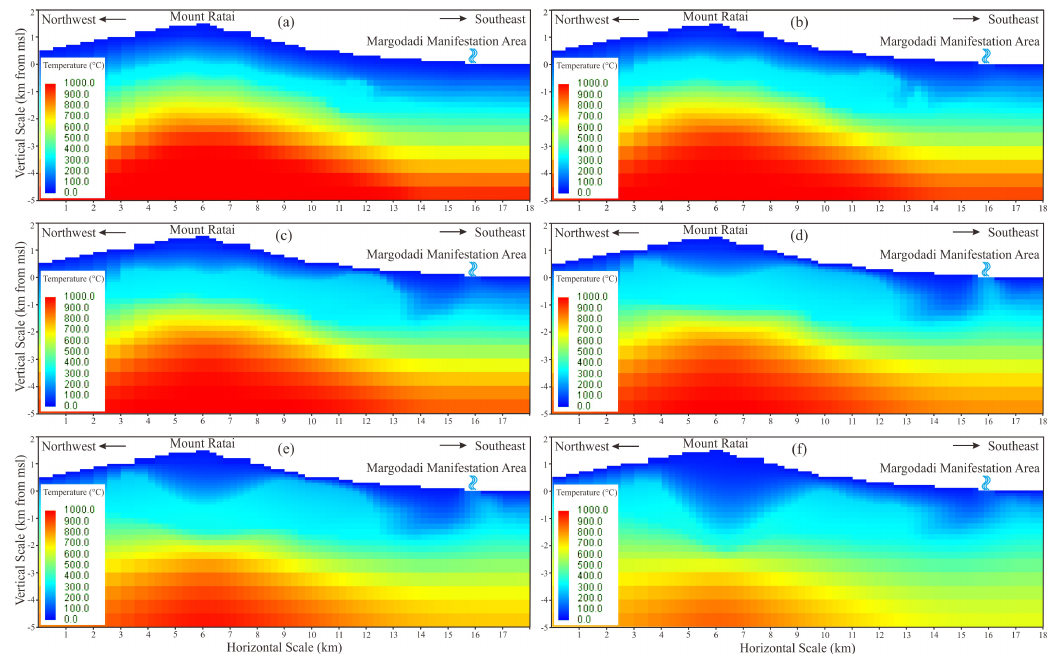
Fig. 5. (a-f) the simulation results showing the numerical model of Way Ratai temperature reservoir using 1,000 to 100,000-year